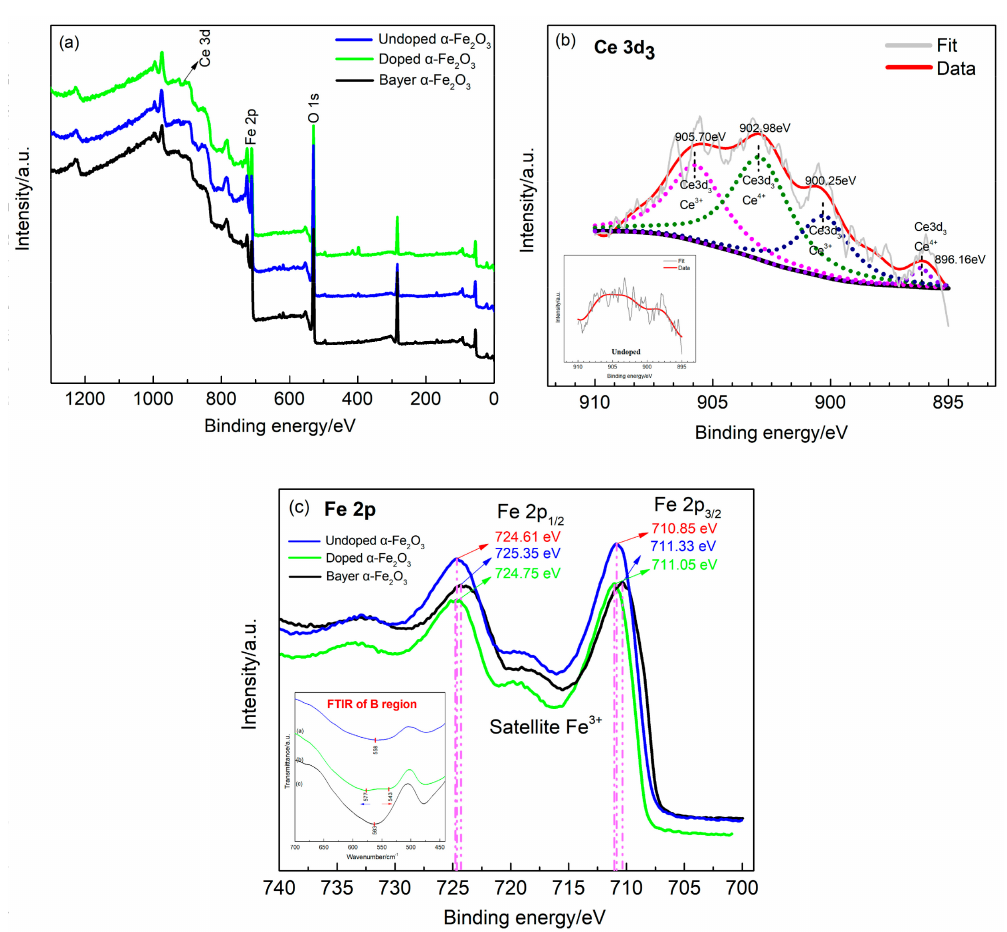
Figure 7. Survey XPS (X-ray photoelectron spectroscopy) spectrum of samples. ( a ) Representative XPS survey spectrum of three samples; high resolution XPS spectra of ( b ) Ce 3d; ( c ) Fe 2p.